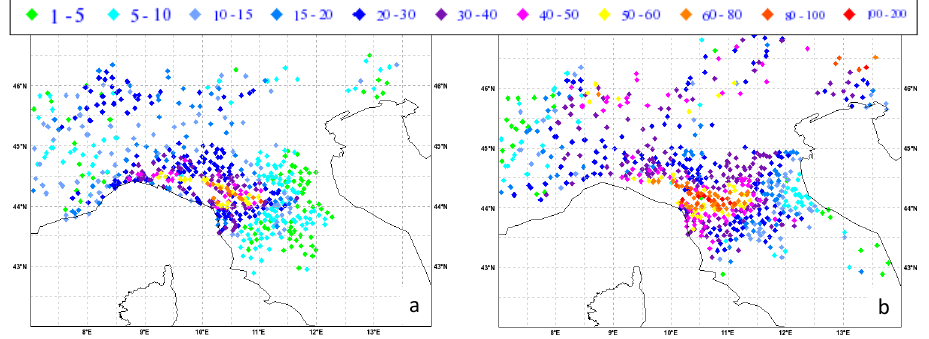
Fig. 3. Observed precipitation (mm) for the two periods of most intense rainfall: (a) 6h accumulated rainfall at 00:00UTC, 30 Novem- ber 2008; (b) 24h accumulated rainfall at 12:00UTC, 1 December